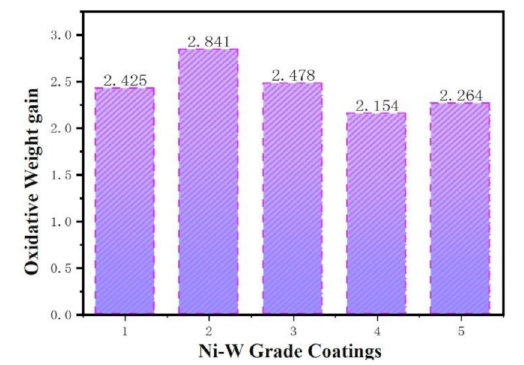
Figure 10. Experimental results verified the oxidation weight gain of BP optimized